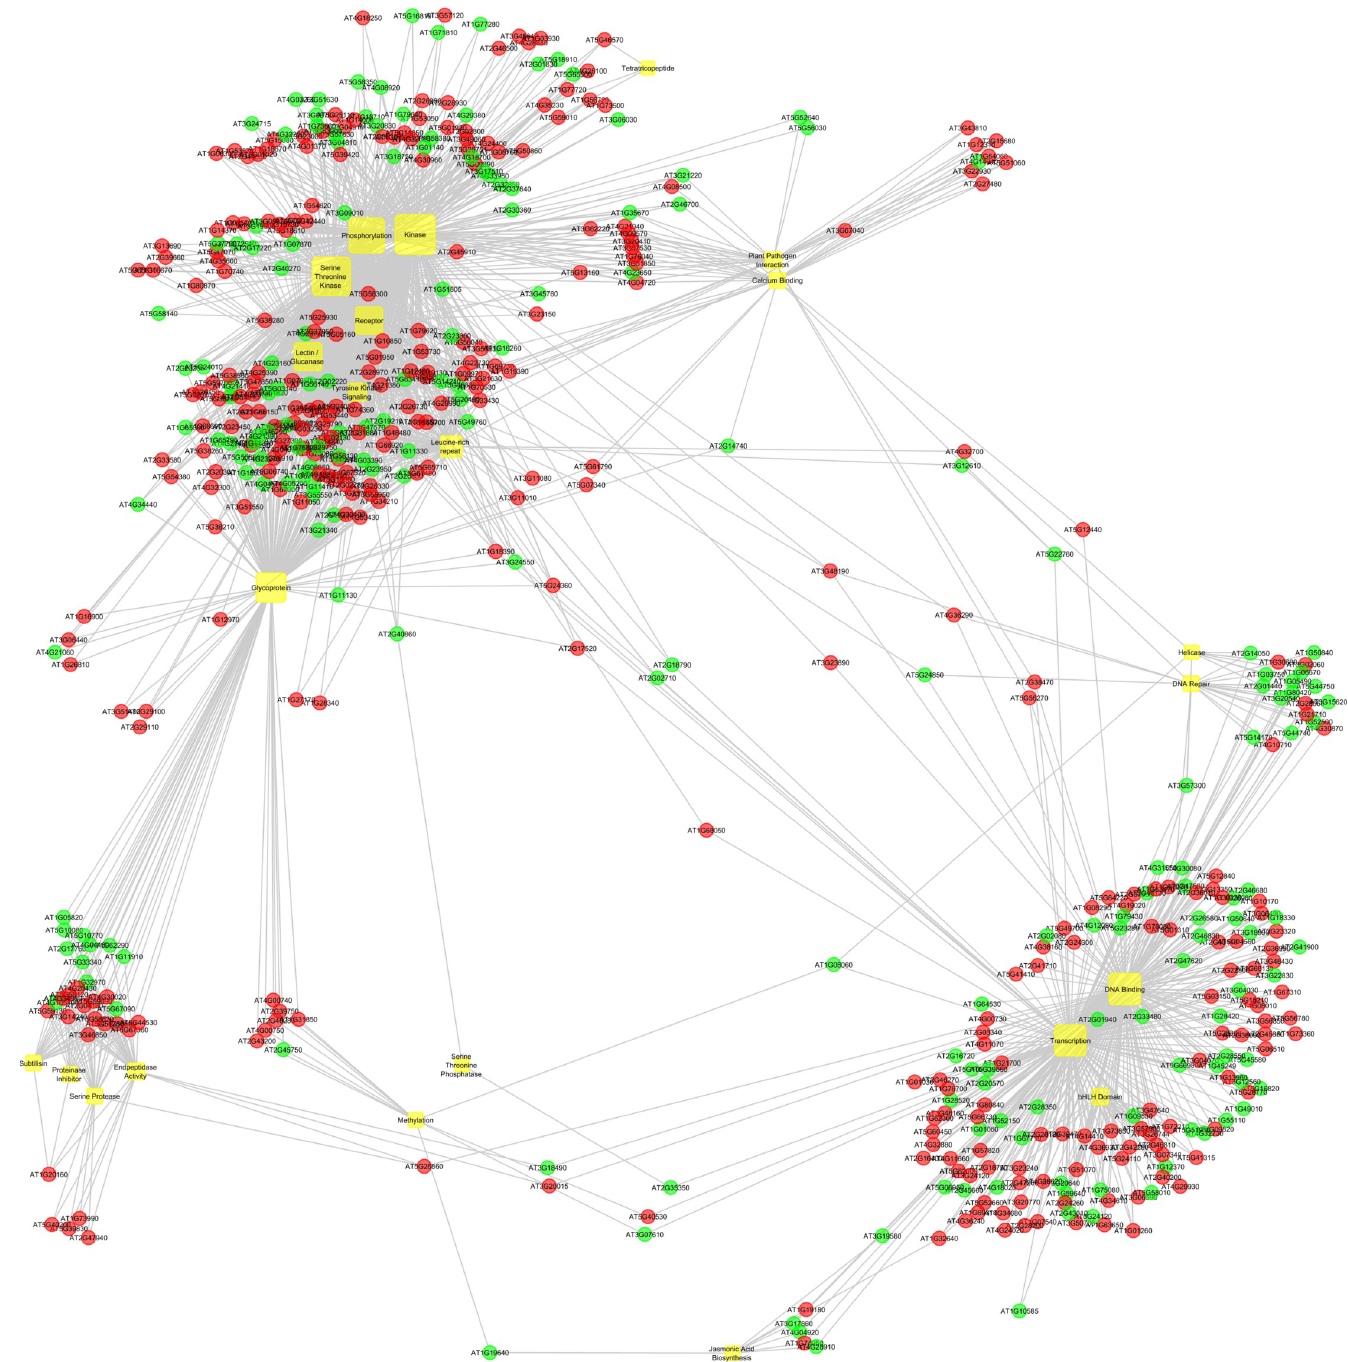
Fig 7. Biological categories-based network analysis depicting connection between the genes mapped in different MapMan bins.